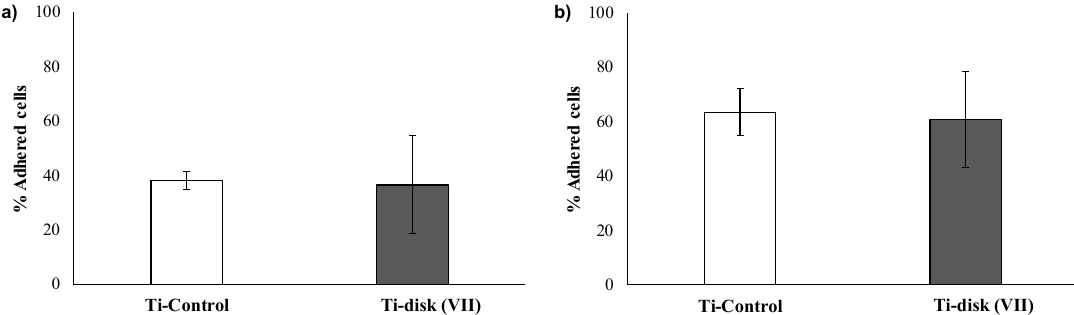
Figure 3. Adhesion of osteoblastic cells to nude Ti 6 Al 4 V extralow interstitials (ELI) disks (Ti Control) and tripeptide arginine-glycine-aspartic acid (RGD)-coated disks (Ti disk (VII)), in ( a ) the normal growth medium and ( b ) the low-serum medium.